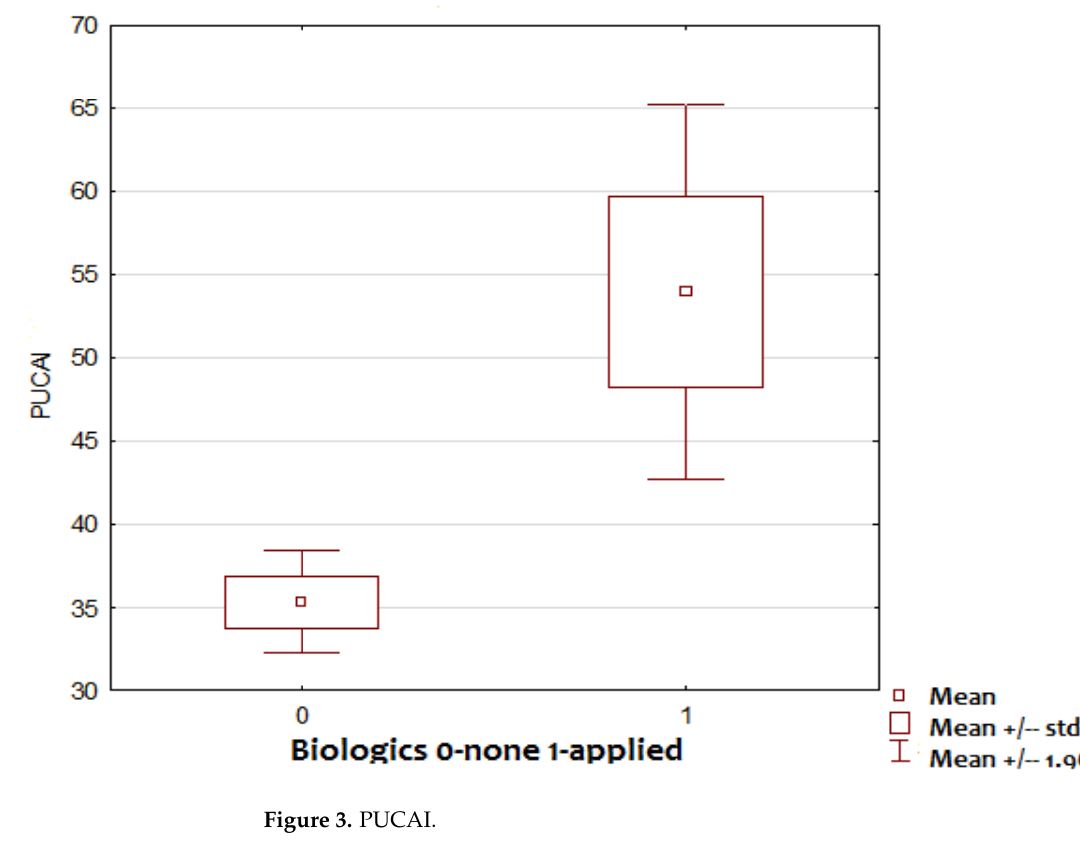
Figure 3. PUCAI. Figure 3.